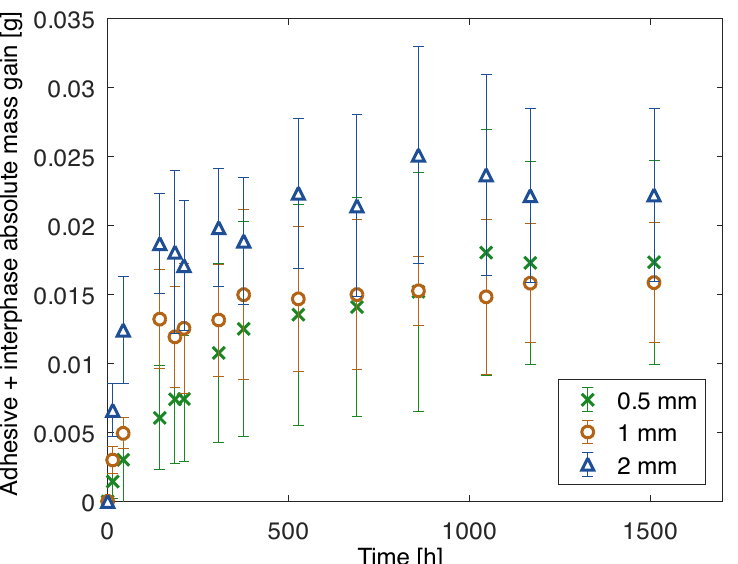
Figure 15. Mass gain due to water uptake of adhesive and interphase of joints with aluminum substrates and 0.5 mm, 1 mm, and 2 mm thick adhesive.